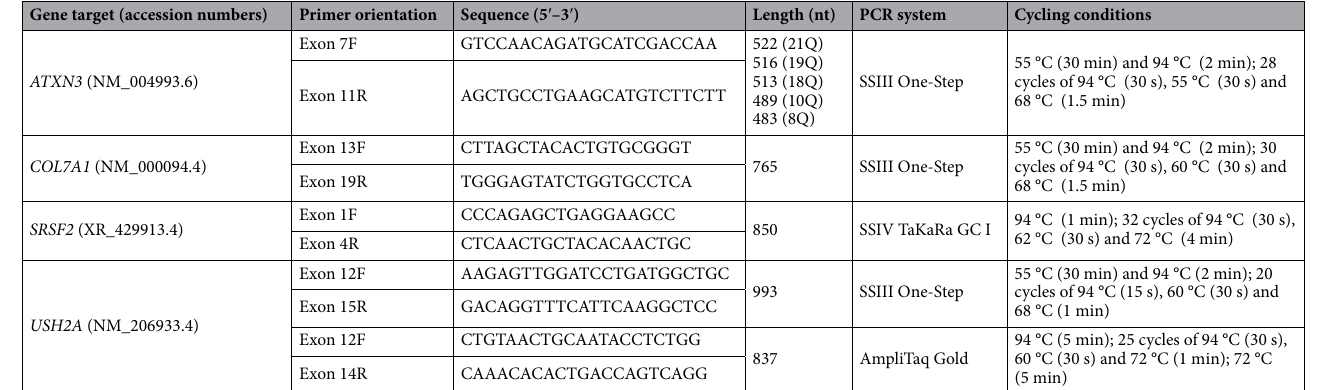
Table 5. List of primers, PCR system and conditions used in this study.